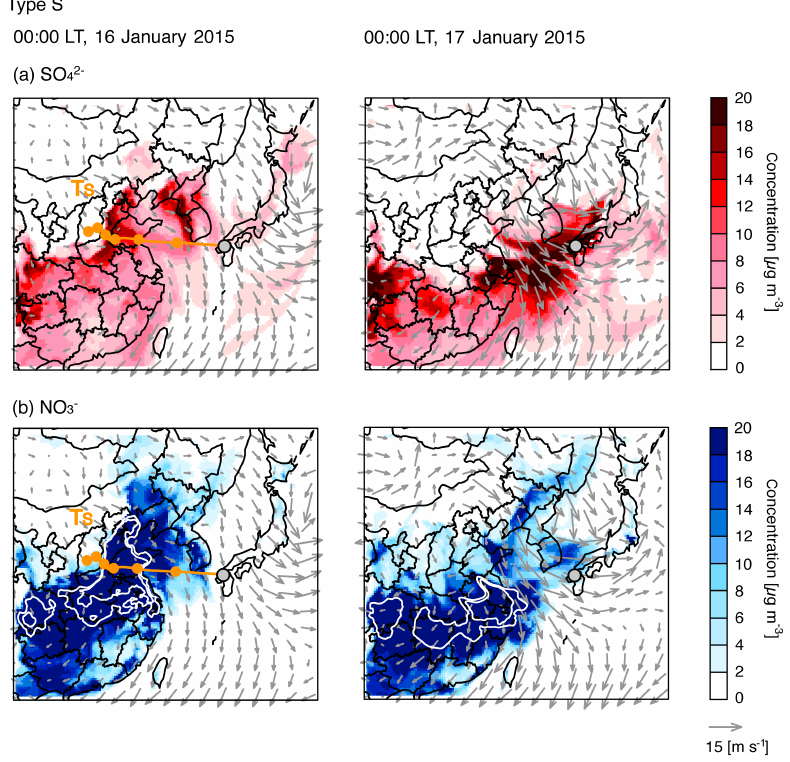
and (b) NO − during a type S pattern. The contours shown by the white lines for 4 3